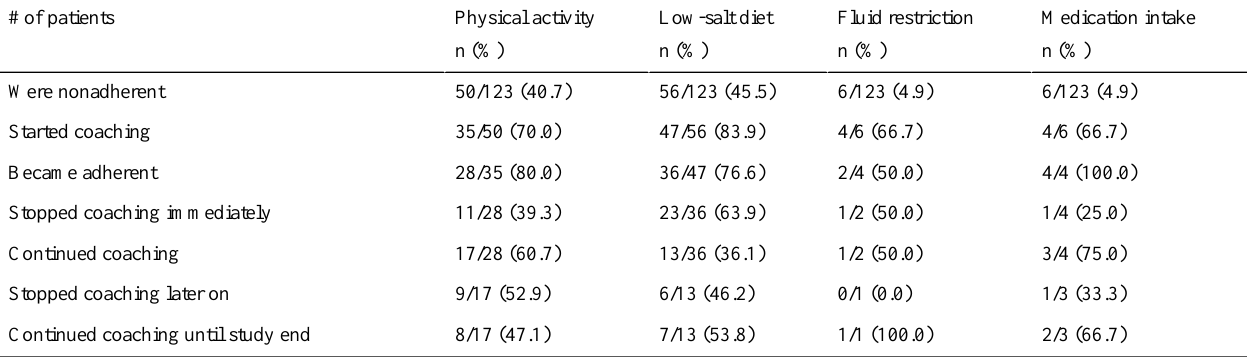
Table 2. Number of patients who entered a state per self-care behavior (N=123).